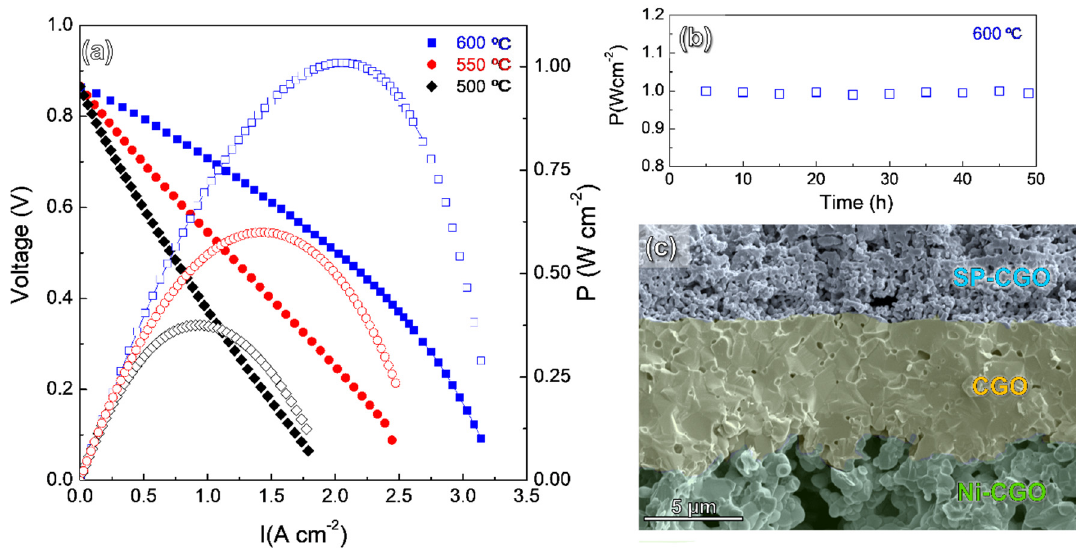
Figure 6. ( a ) I–V and the corresponding power density curves of the Ni-CGO supported cell with BCFZY cathode at different temperature. ( b ) Power density over time at 600 °C. ( c ) Cross-sectional SEM image of the cell after electrochemical test .